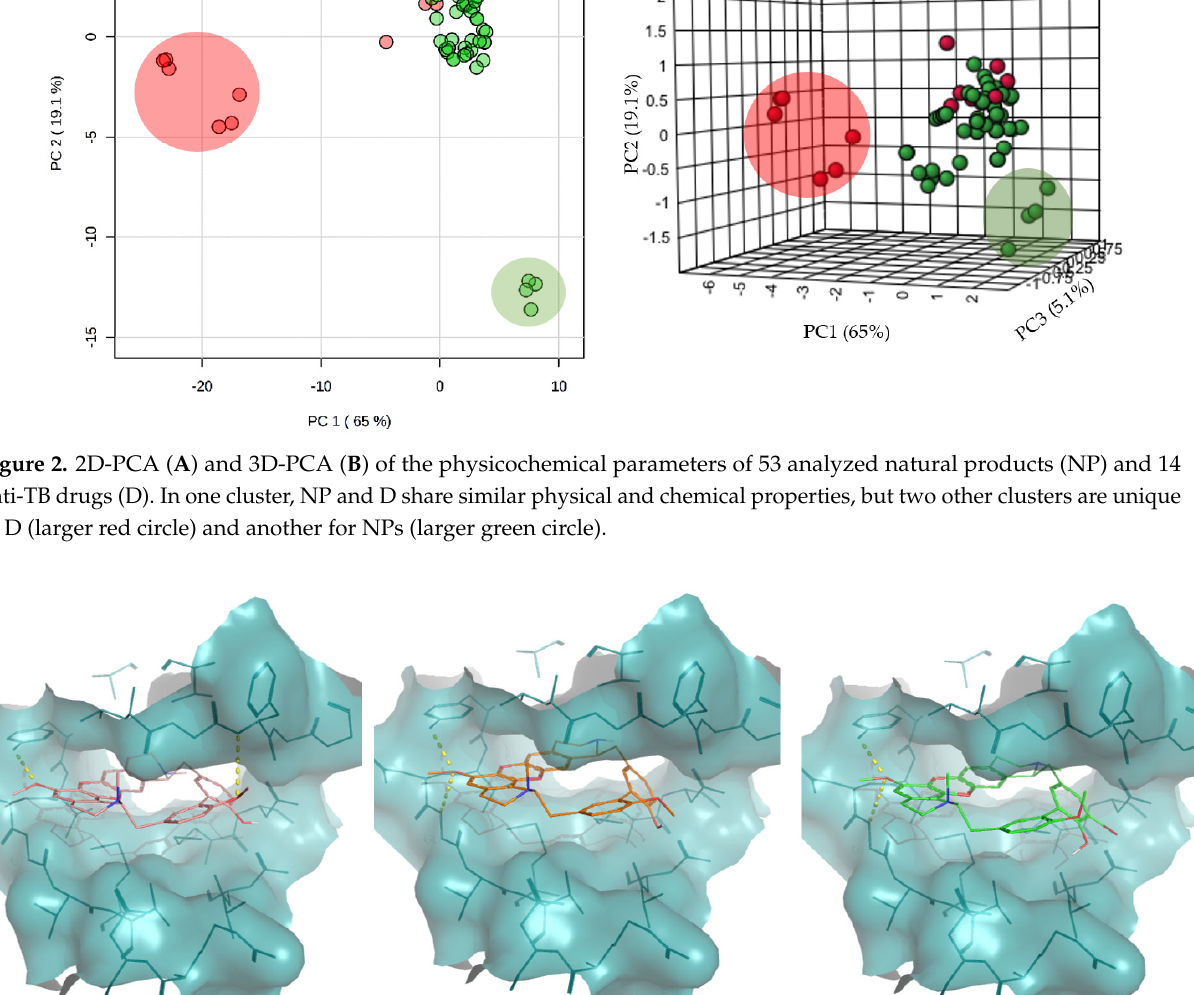
Figure 3. Molecular interactions of the best docking positions of tiliacorine ( A ), nortiliacorinine ( B ) and 13 ′ -bromotili- acorine ( C ) against PknB. Hydrogen bonds are shown as yellow dashed lines.